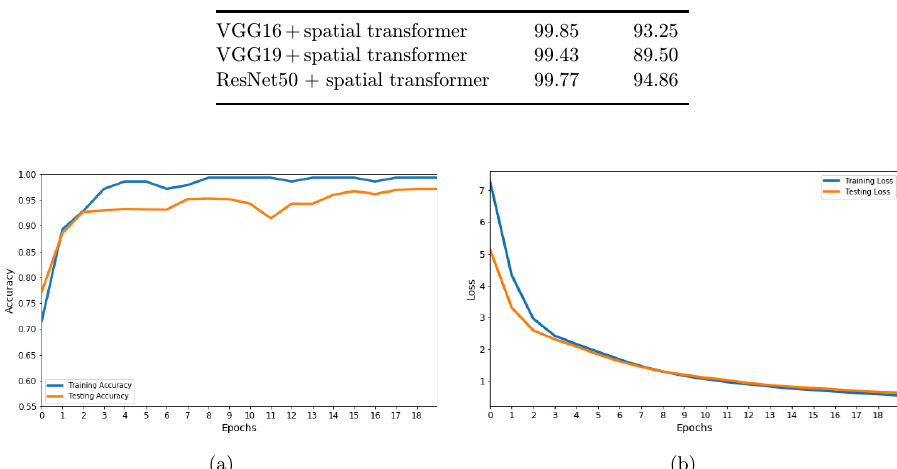
Fig. 11. Graph of the VGG16 þ LSTM model: (a) Epochs vs. Accuracy (b) Epochs vs. Loss.